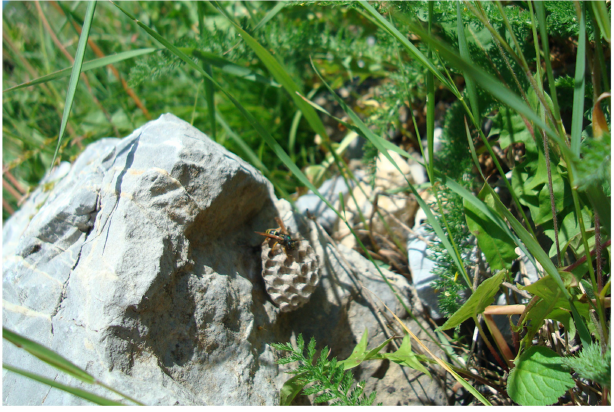
Figure 1. A Polistes biglumis nest built on a rock close to the